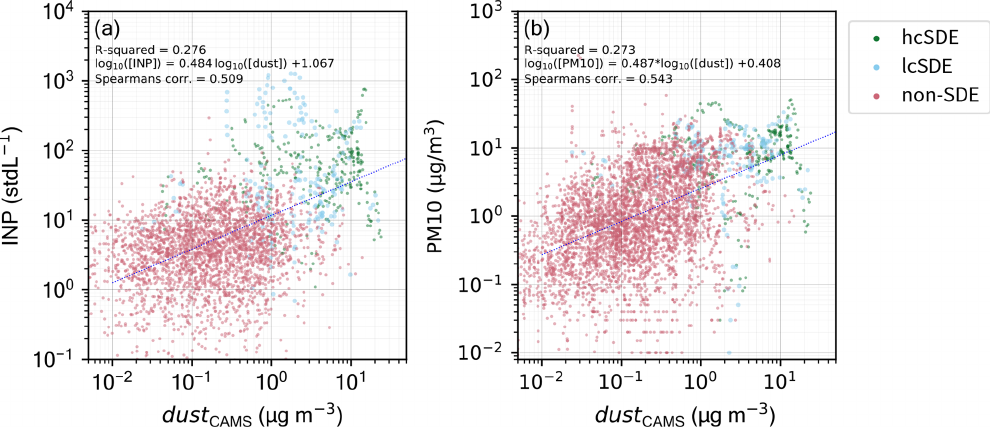
Figure 7. The variable dust CAMS mass concentrations with simultaneously measured INP number concentrations ( a ) and dust CAMS mass concentrations with simultaneously measured PM 10 concentrations in ( b ), each for periods of high-confidence Saharan dust events (hcSDEs), low-confidence Saharan dust events (lcSDEs), and non-SDEs, with the corresponding correlation parameters and linear fits (blue line). For either plot, the dust CAMS concentrations were linearly interpolated to the sampling frequency of the INP measurements (20min) and PM 10 measurements (10min),